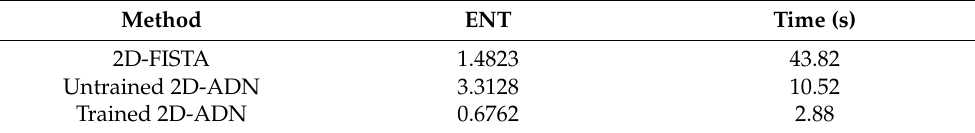
Table 5. Quantitative performance evaluation for the incomplete azimuth simulation